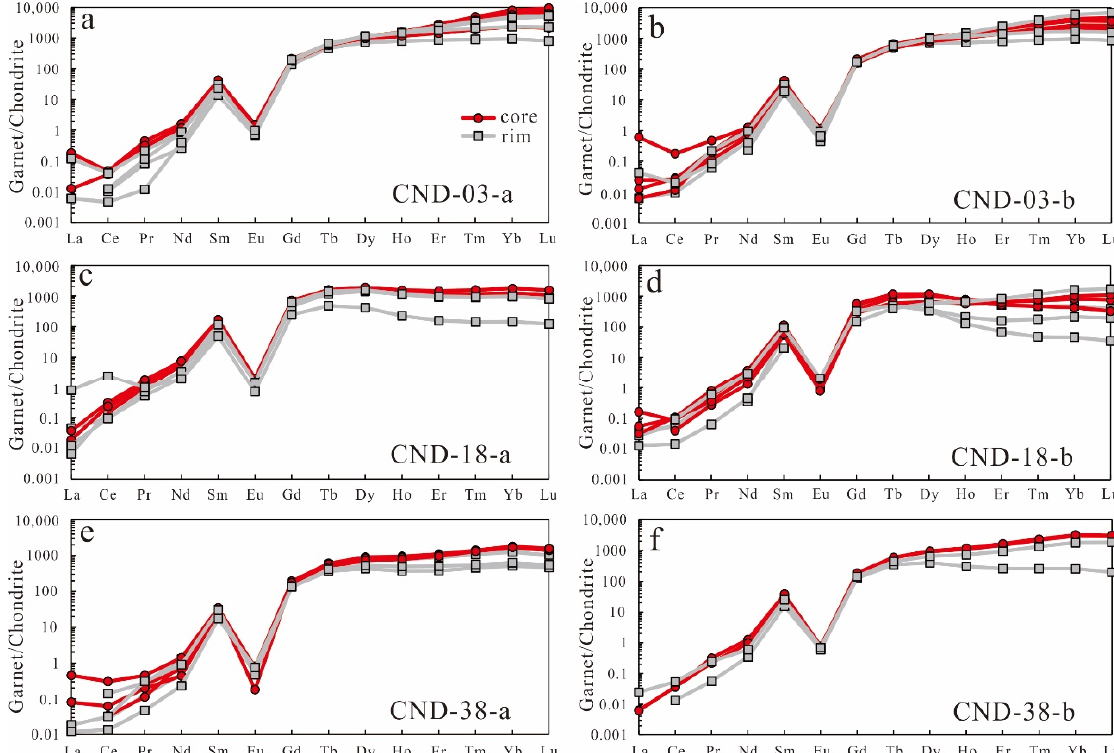
Figure 8. Chondrite-normalized REE patterns of garnets: ( a , b ) garnets from the muscovite granite; ( c – f ) garnets from the pegmatite (chondrite normalization data from [63]).